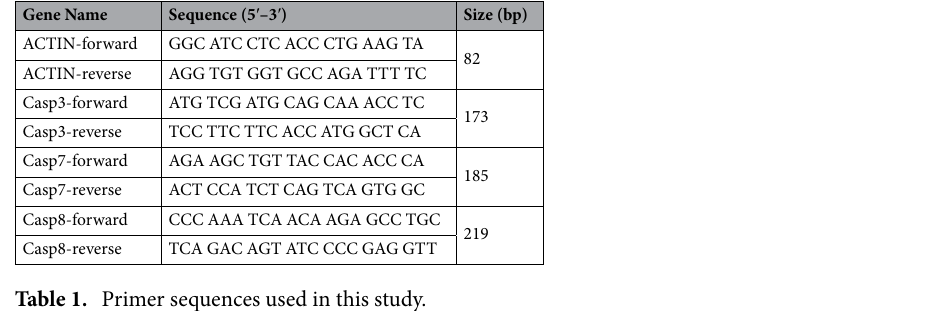
Table 1. Primer sequences used in this